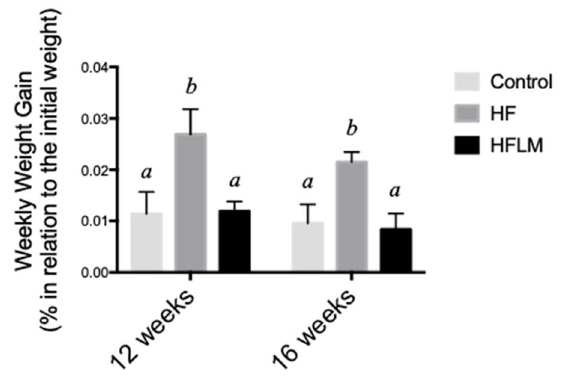
Figure 2. The effect of control, High-Fat (HF), or low in methyl donors (HFLM) diets on growth. Results are weekly weight gain (% of initial weight). Data shown are the mean ± SEM; n = 5–6/group, bars not sharing superscript letters differ from each other, p < 0.05.